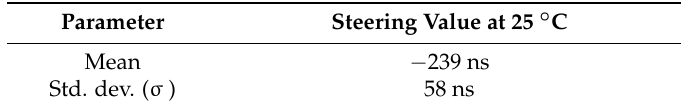
Table 6. Calculated steering values statistics at 25 ◦